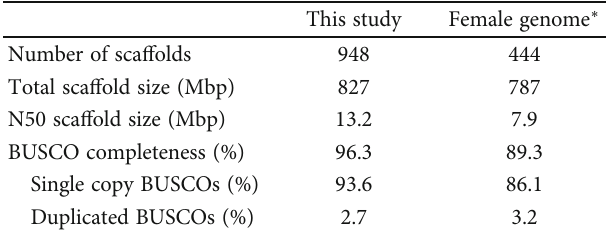
Table 1: Assembly statistics of PBT genomes.